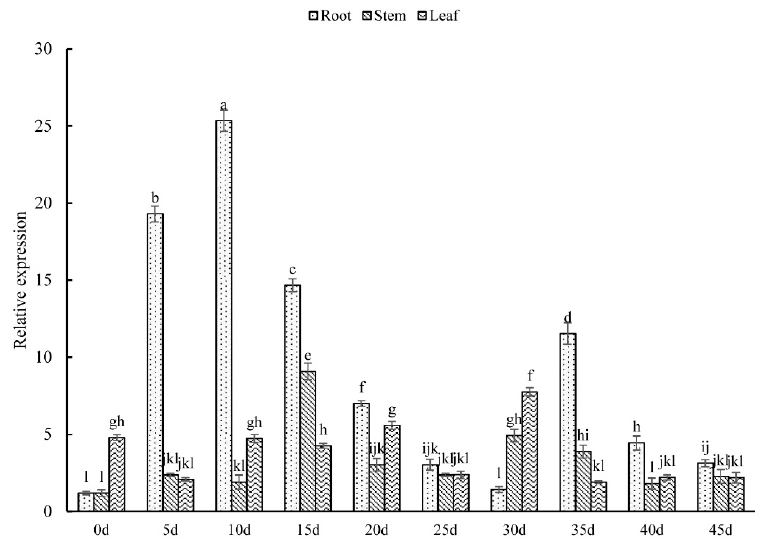
Figure 4. Relative expression level of PsARRO − 1 in different parts of Paeonia suffruticosa in vitro. Different letters within the columns indicate significant differences ( p < 0.05) according to the Tukey test.